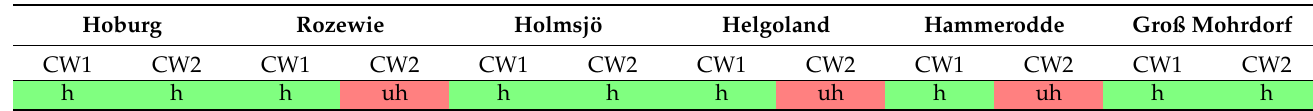
Table 2. Daytime: signals used for the position and time estimation in green with the “h” flag. Signals in red with the “uh” flag were not used.